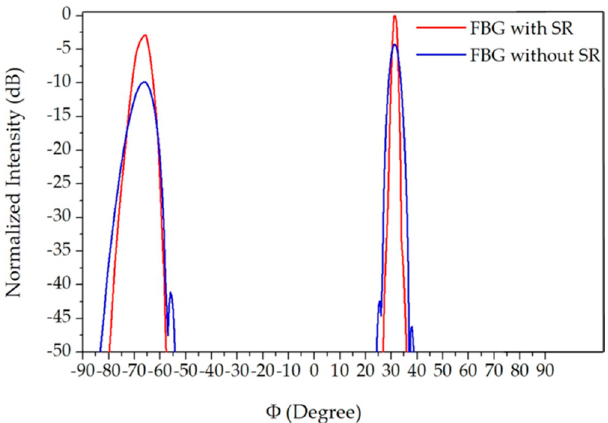
Figure 8. θ -directional strength is compared between SR-based linear attenuation (red line) with the chirped FBG and conventional antennas (blue line).